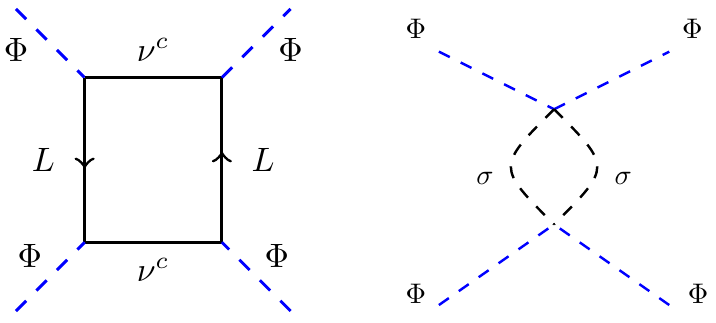
Figure 3 . Left panel : the destabilizing effect of right-handed neutrinos on the evolution of the Higgs quartic coupling. Right panel : one-loop correction to the Φ quartic coupling due to its interaction with the singlet σ that drives spontaneous lepton number violation in dynamical inverse seesaw